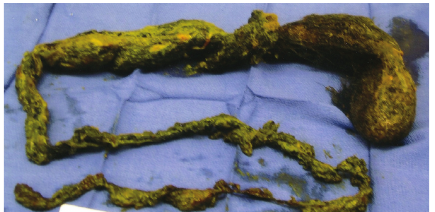
Figure 4: A 100cm long gastroduodenal trichobezoar that was removed by gastrotomy. The larger portion at the top right corner of the image was located in the stomach. Notice how the mass decreased in width as it extended further down into the small